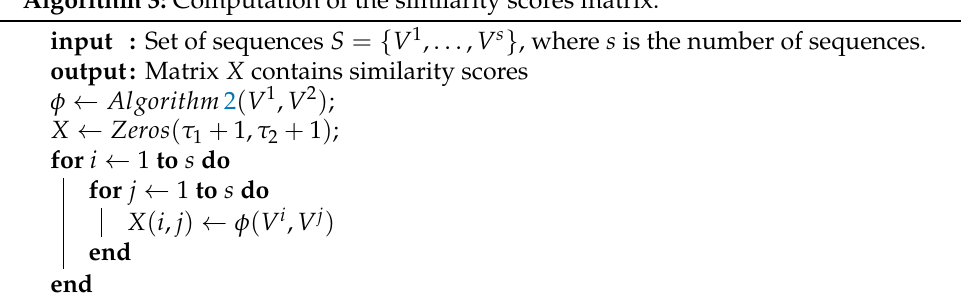
Algorithm 3: Computation of the similarity scores